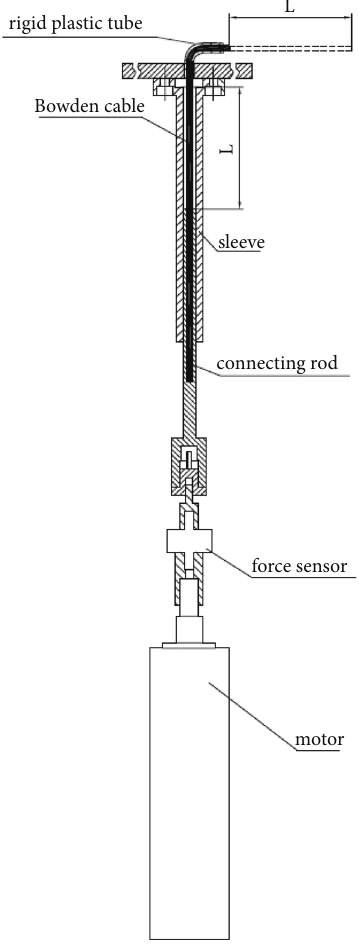
Figure 3: Mechanical structure to guarantee cable sti ff